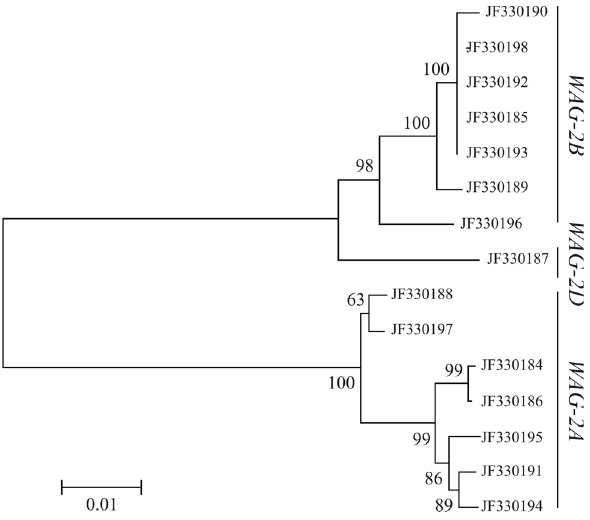
Figure 2 - Neighbor-joining phylogenetic tree. The GenBank accession numbers (JF330184 to JF330198) for the cloned WAG-2 sequences are showninTable1.Bootstrapvaluesareshownaspercentagesfor1000rep-